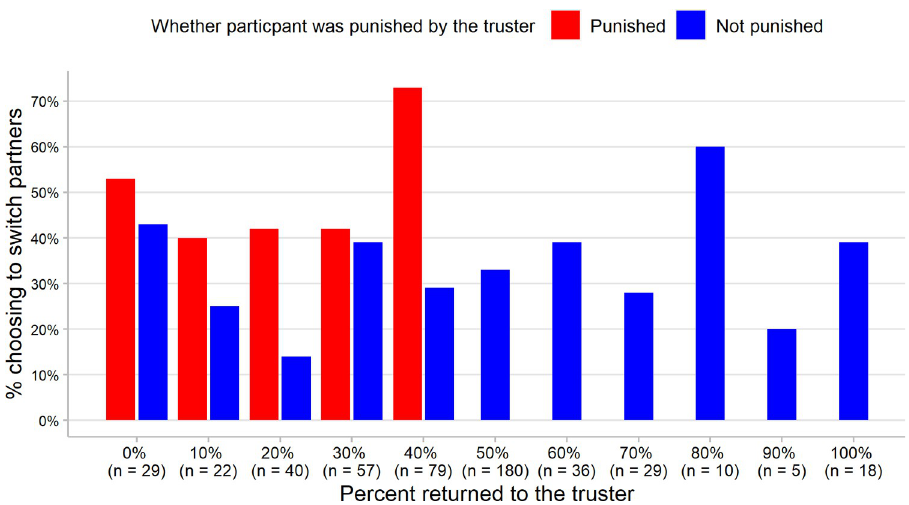
Fig 3. Probability of switching partners as a function of how much the participant returned and whether the participant was punished. The y-axis shows the percentage of participants who decided to switch partners in the High Partner Choice condition. The x-axis shows what percent of 210 points the participant (responder) returned to the partner (truster). (How many individuals returned each amount is shown in parentheses.) Red bars: participants whose partner punished them by deducting 60 points; blue bars: participants who were not punished by their partner.